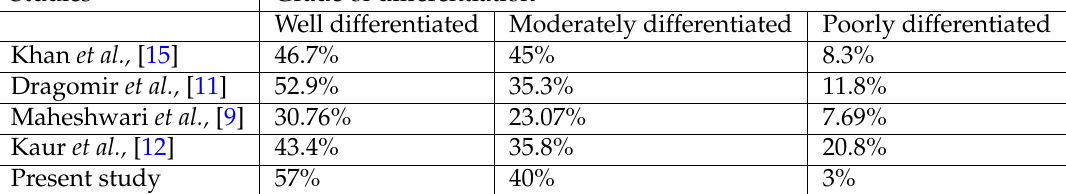
Table 6. Grade of differentiation in other